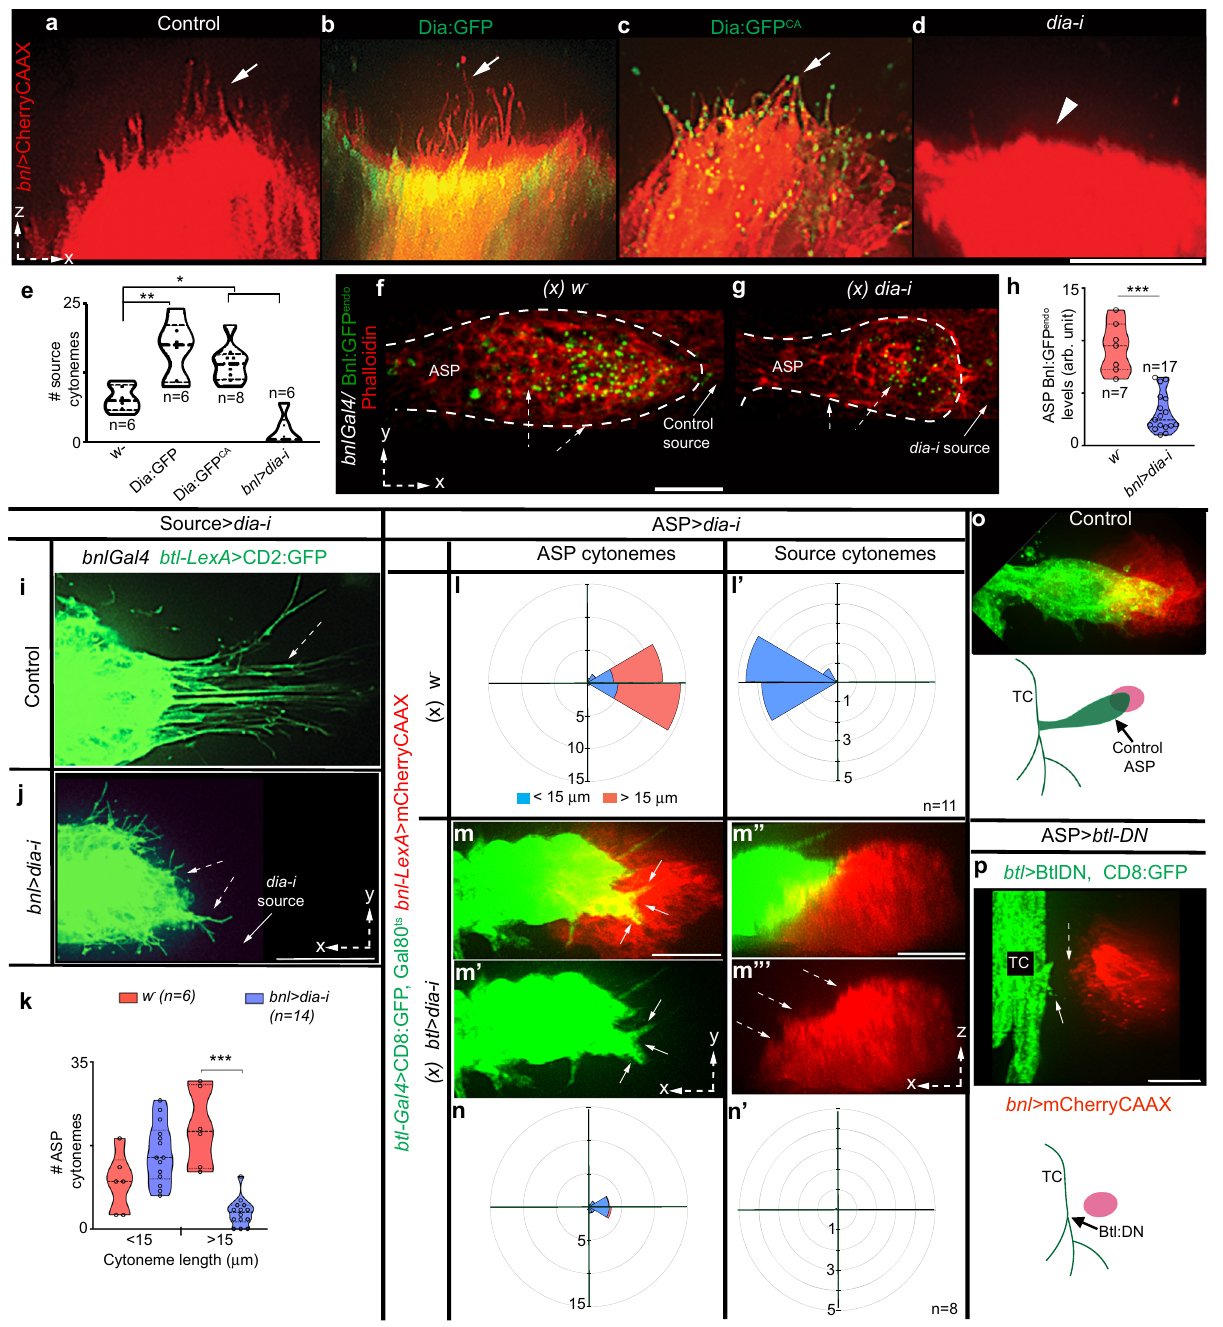
Fig. 2 Bidirectional matchmaking of Bnl-sending and -receiving cytonemes. a – e 3D-rendered views of mCherryCAAX-marked bnl- source, showing autonomous effects of Dia:GFP, Dia:GFP CA , and diaRNAi expression on source cytoneme numbers ( UAS-mCherryCAAX;bnl-Gal4 X w - for control, or UAS- “ X ” ); arrow, source cytonemes, arrowhead, missing source cytonemes. e Violin plots showing numerical values; p values (one-way ANOVA followed by Tukey ’ s honestly signi fi cant different (HSD) test) — p < 0.05 (*) and p < 0.01 (**). f – h Levels of Bnl:GFP endo uptake (dashed arrow) in the ASP (dashed line) from wild-type source cells ( f ; control: bnl:gfp endo X bnl-Gal4 ) and from dia-i- expressing source cells ( g ; source cytoneme-depleted condition: UAS-dia- i,bnl:gfp endo X bnl-Gal4 ), h Violin plots showing numerical values, as indicated; p value (***) — 0.06 × 10 − 5 (unpaired two-tailed t test). i – k Comparison of numbers of CD2:GFP-marked ASP cytonemes (dashed arrow) of various length produced under the control condition and under dia-i- induced source cytoneme depleted conditions as indicated. k violin plots showing numerical values as indicated; p value (***) — 0.076 × 10 − 5 (unpaired two-tailed t test). e , h , k Violin plots: black dotted lines show the median as well as 25th and 75th percentiles. l – n ’ Non-autonomous effects of dia-i- induced depletion of ASP cytonemes (arrows; m , m ’ ) on source cytonemes (dashed arrows; m ” , m ’” ); l , l ’ , n , n ’ R-plots, showing the correlation of ASP and source cytoneme number, length and orientation in control ( l , l ’ ; w- ) and btl > dia-i condition ( n , n ’ ); see Supplementary Table 2 for statistical values. e , h , k , l , l ’ , n , n ’ sample size ( n ) — numbers of independent wing discs/per genotype. o , p The Btl-DN- induced depletion of ASP cytonemes (arrow) non-autonomously depleted source cytonemes (dashed arrow); genotypes — btl-Gal4,UAS- CD8GFP/ + ; bnl-LexA,LexO -mCherryCAAX/ + ( o ); btl-Gal4,UAS- CD8GFP/ + ; bnl-LexA,LexO - mCherryCAAX/ UAS - Btl-DN ( p ). All panels (except f , g ), live imaging. Source data are provided as a Source data fi le. Scale bars, 20 μ m. NATURE COMMUNICATIONS| (2022) 13:3482